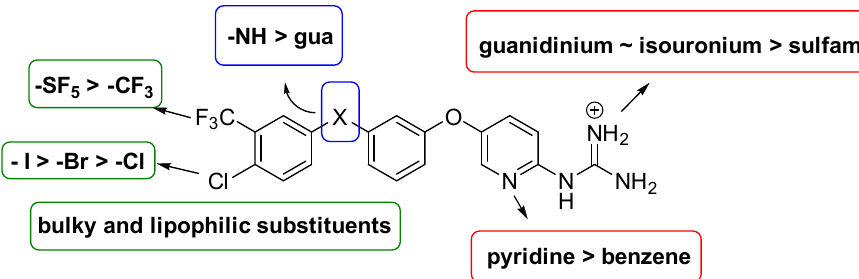
Figure 4. Structure Activity Relationship (SAR) deduced from the analysis of the HL-60 cytotoxicity results.